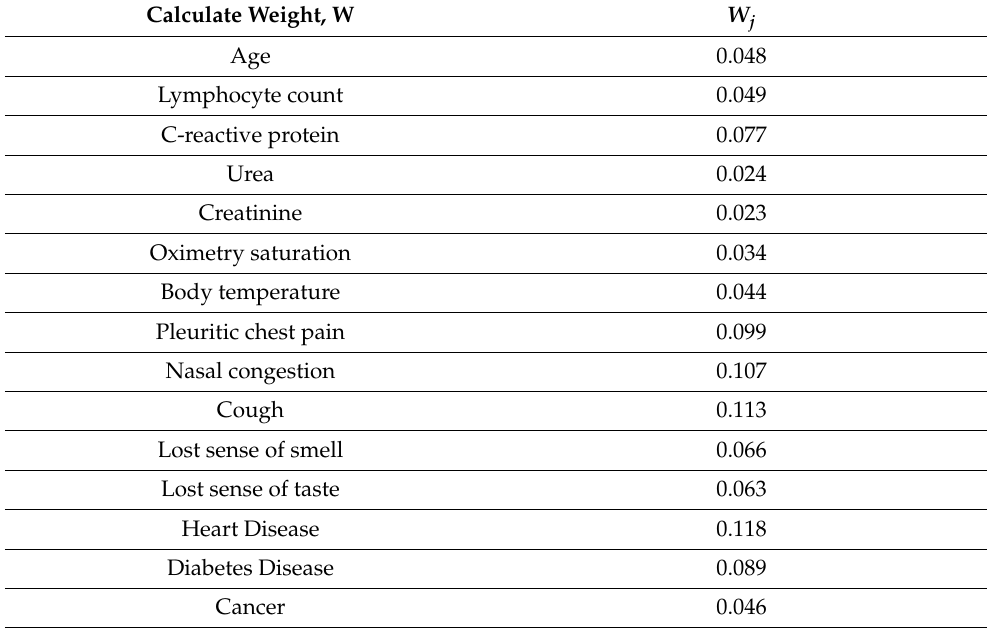
Table 4. The criteria weights’